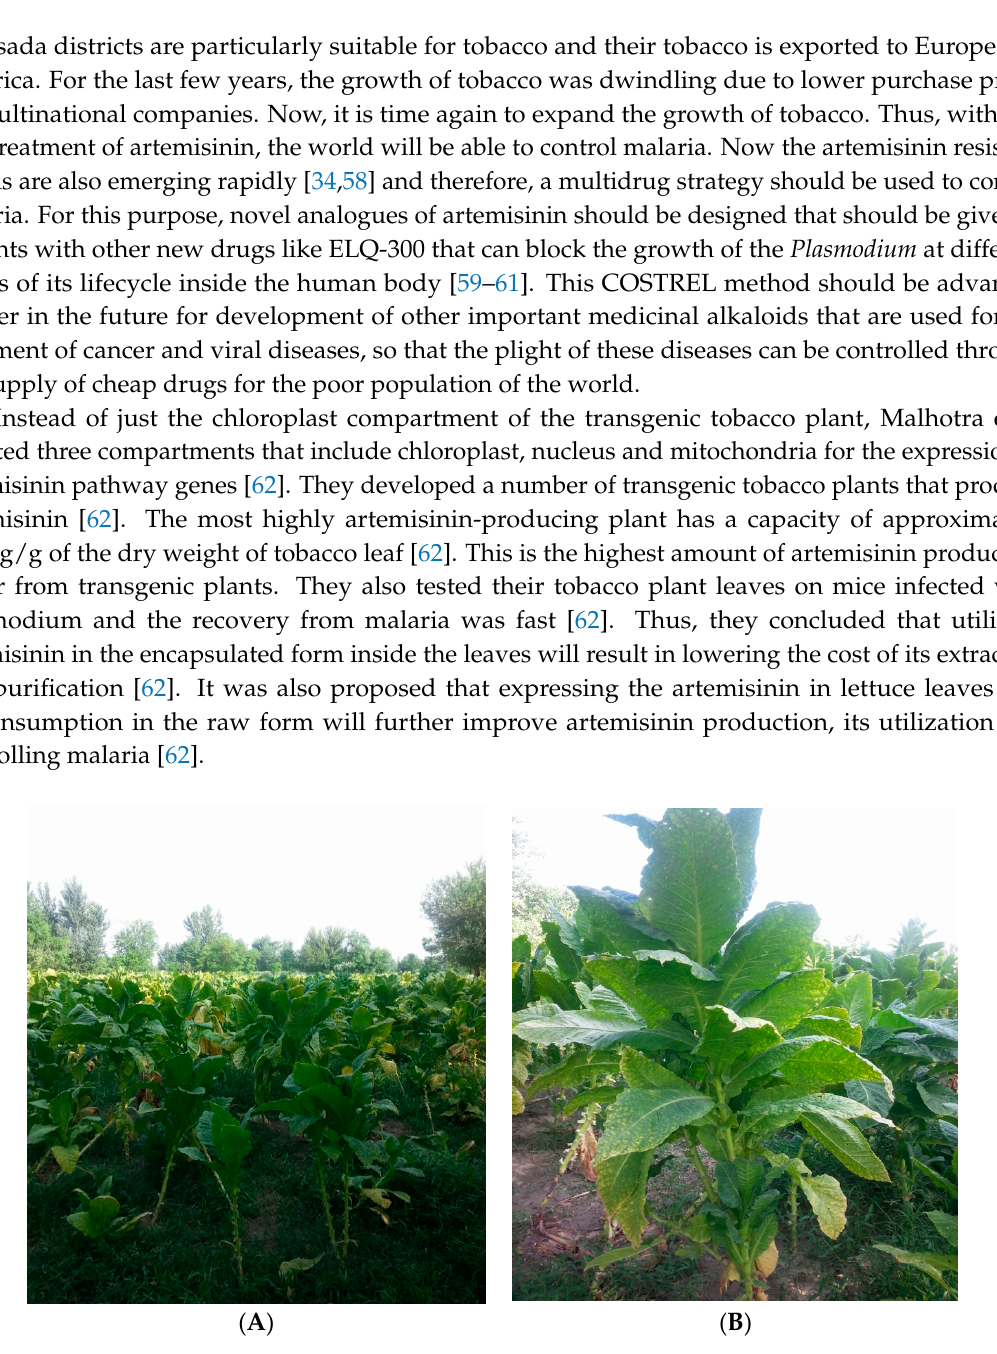
Figure 2. ( A ) Mature tobacco plants growing in the field of district Swabi, Pakistan; ( B ) The large size leaves of tobacco are suitable for the mass scale production of artemisinin.